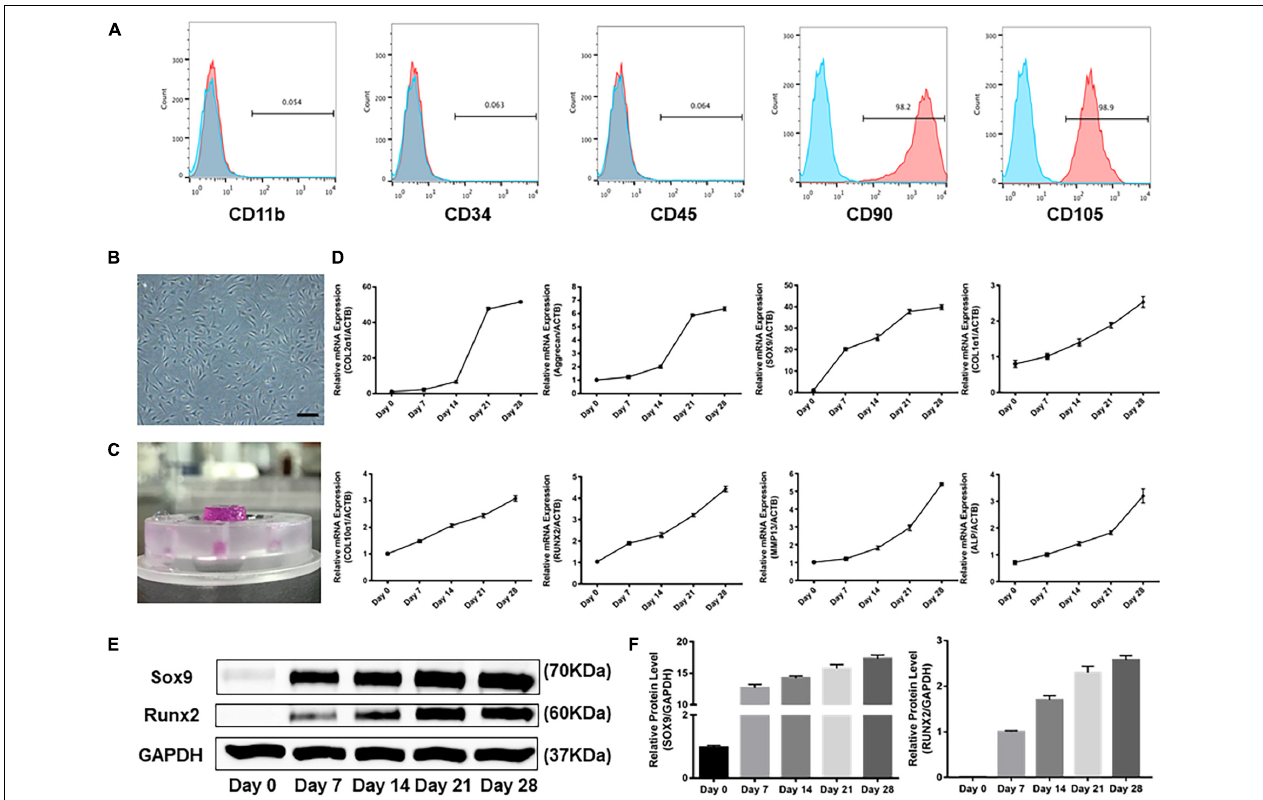
FIGURE 2 | Profiles of human SMSCs in this experiment. (A) Flow cytometric analysis of human SMSCs at passage 3. SMSCs were positive for CD90 and CD105, while negative for CD11b, CD34, and CD45. (B) SMSCs at passage 3. (C) Patterns of SMSC constructs. (D) Gene expression of chondrogenesis and hypertrophy development was examined at days 0, 7, 14, 21, and 28. (E) Western blot analysis of expression level of SOX9 and RUNX2. (F) Expression level of SOX9 and RUNX2 was shown in the histograms normalized with GAPDH. COL2 α 1, collagen type II; SOX9, SRY-box transcription factor 9; COL1 α 1, collagen type I; COL10 α 1, collagen type X; RUNX2, RUNX family transcription factor 2; MMP13, metalloproteinases 13; ALP, alkaline